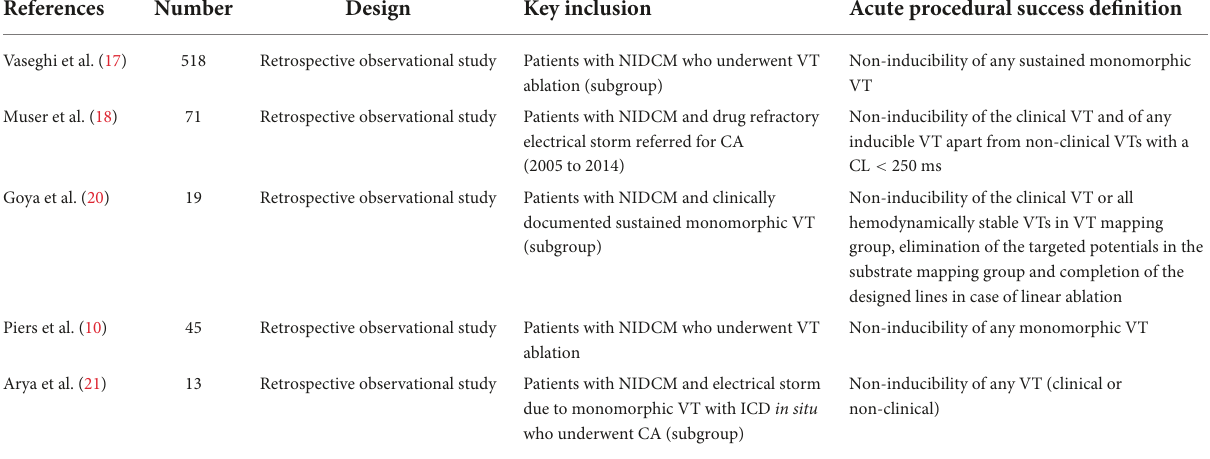
TABLE 1 Baseline study